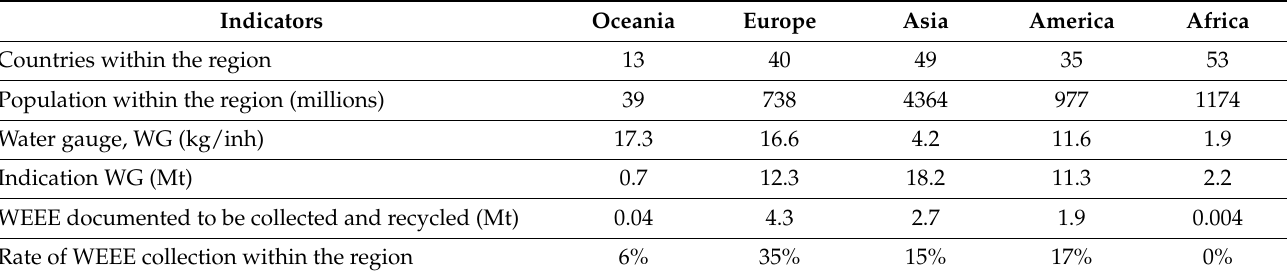
Table 2. The generators of WEEE and its collection per